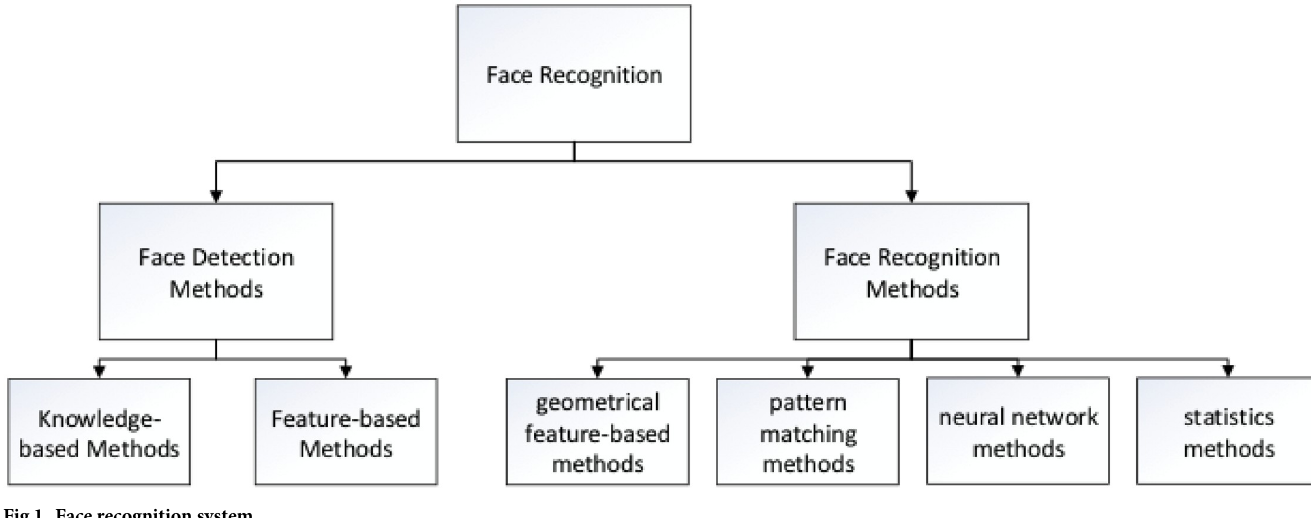
Fig 1. Face recognition